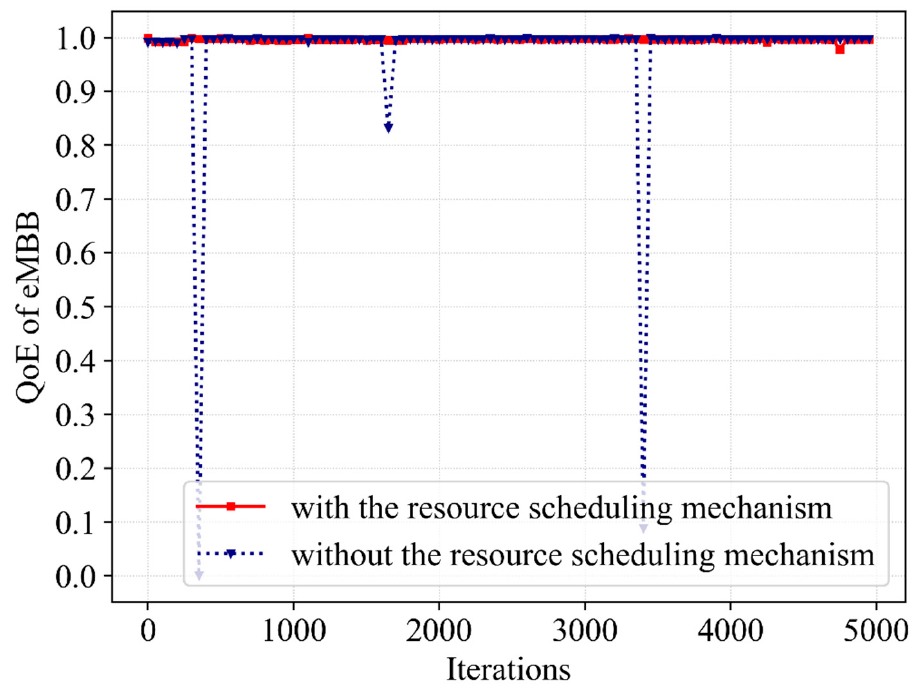
Figure 7. A comparative result of QoE for eMBB service with and without the resource scheduling mechanism.